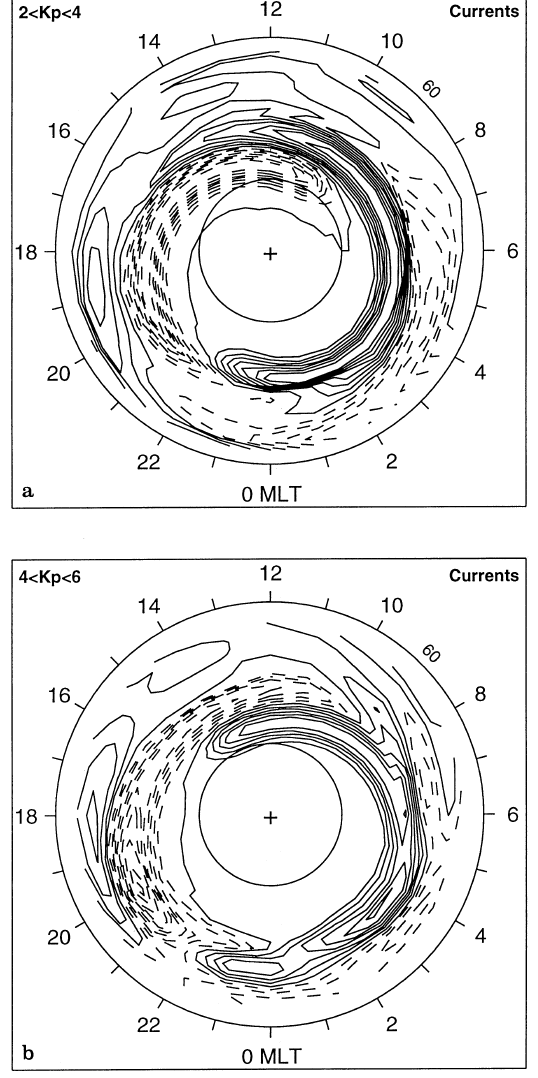
Fig. 2a,b. Isocontours of the field-aligned currents represented in polar maps similar to Fig. 1. The contour interval is 0.075 (cid:108) A/m 2 for a 2 < Kp < 4 and b 0.12 (cid:108) A/m 2 for 4 < Kp < 6